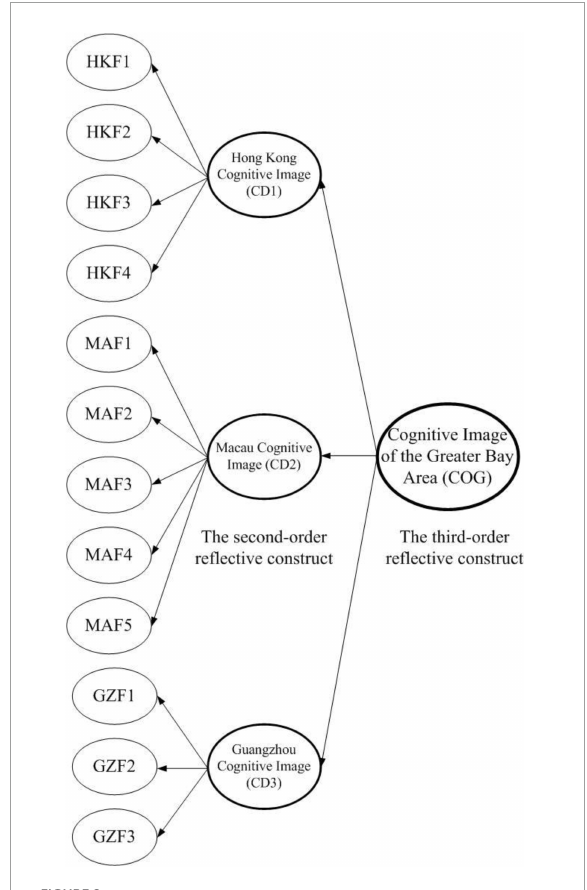
FIGURE2 The structure of the overall cognitive image of the